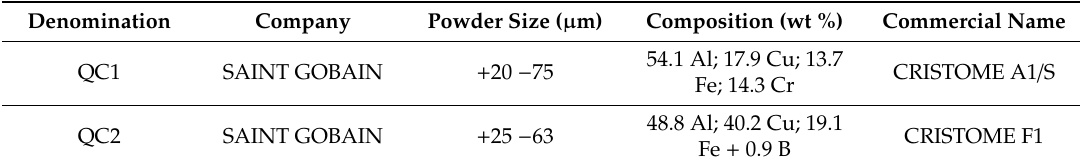
Table 2. Powders employed to deposit the corresponding coatings by High Velocity Oxyfuel (HVOF).